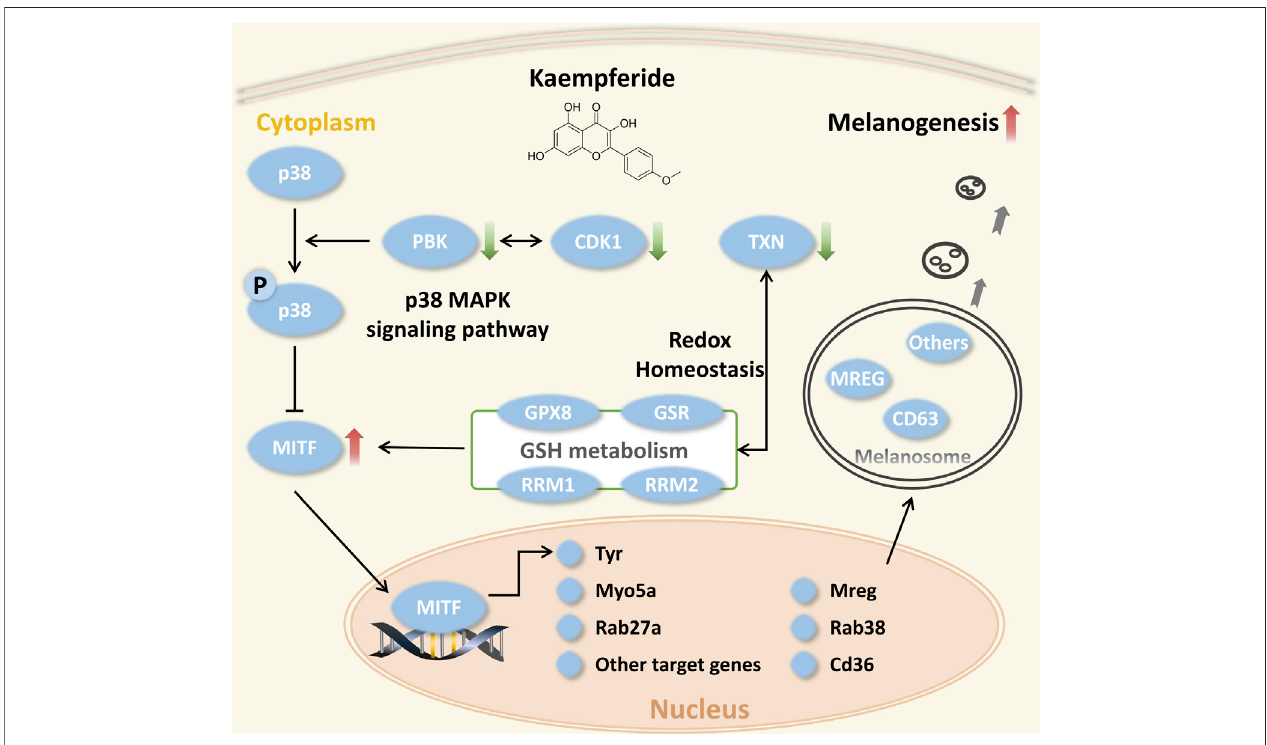
FIGURE 10 | Illustration of the multi-target strategy of kaempferide for vitiligo.